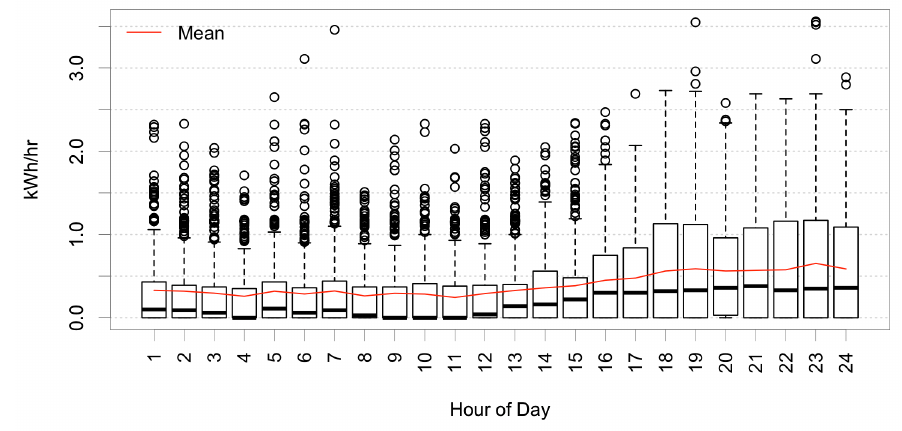
Figure 6. DHW heater energy usage in RBSA home 10388 per hour of day from Q2 2012–Q1 2013 inclusive. Note that there were more outliers but lower interquartile variance in early morning hours.